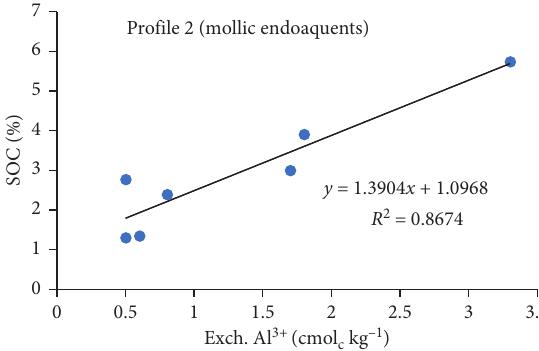
Figure 6: Relationship between SOC and exchangeable Al 3+ in profile 2 (Mollic